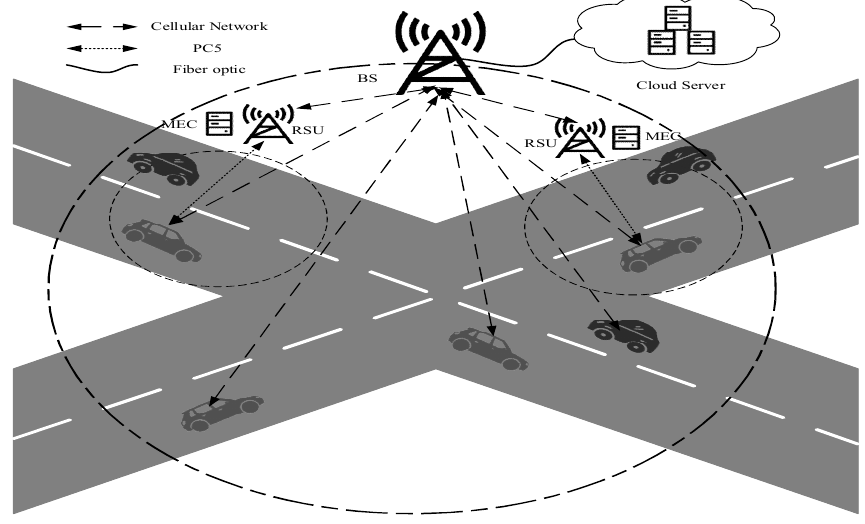
Figure 1. Network model.